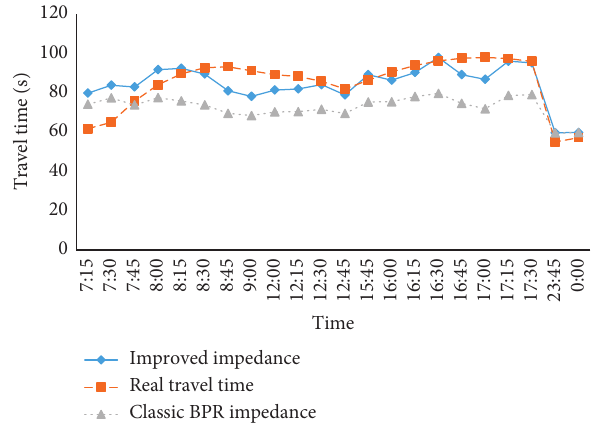
Figure 4: Comparison of travel time predicted by the improved impedance function, the classic BPR function, and the real travel time estimated from GPS